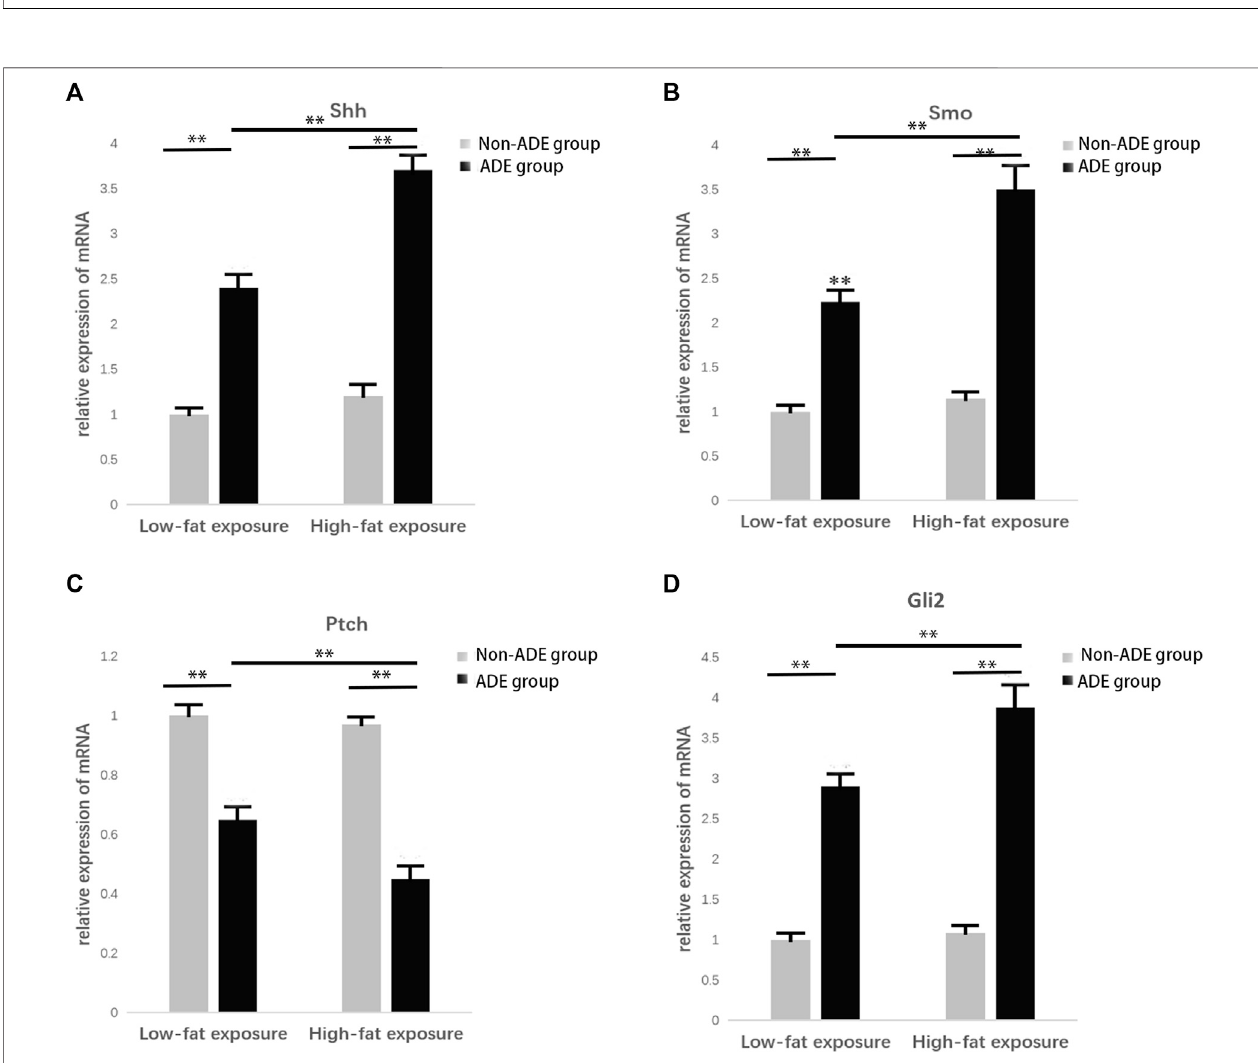
FIGURE4| GeneexpressionintheHedgehogsignalingpathway7 daysaftertreatmentwithADEs. (A) ShhexpressionwasincreasedintheADEgroupcompared to the non-ADE group. (B) Smo expression was increased in the ADE group compared to the non-ADE group. (C) Ptc1 expression was decreased in the ADE group compared to the non-ADE group. (D) Gli2 expression was increased in the ADE group compared to the non-ADE group. * p < 0.05 and ** p < 0.001. Shh, Sonic hedgehog; Smo, Smoothened; Ptc1, Patched 1; and Gli2, glioma-associated oncogene protein 2.